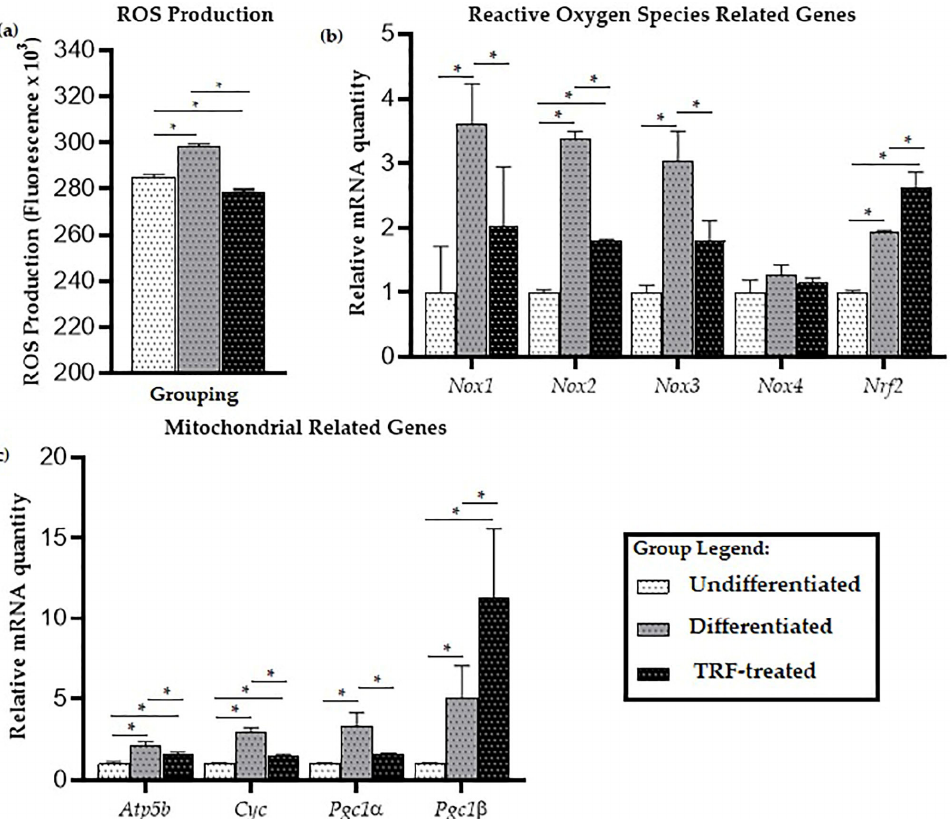
Figure 2. ROS production and expression of mitochondria-related genes: ( a ) The levels of ROS, ( b ) expression of oxidative stress-related genes, and ( c ) mitochondria-related genes in undifferentiated, untreated, and TRF-treated differentiated cells. ANOVA and Tukey’s post-hoc analysis were performed ( a – c ). * indicates p < 0.05. Data are presented as relative quantity ± SD, normalized to the undifferentiated group.